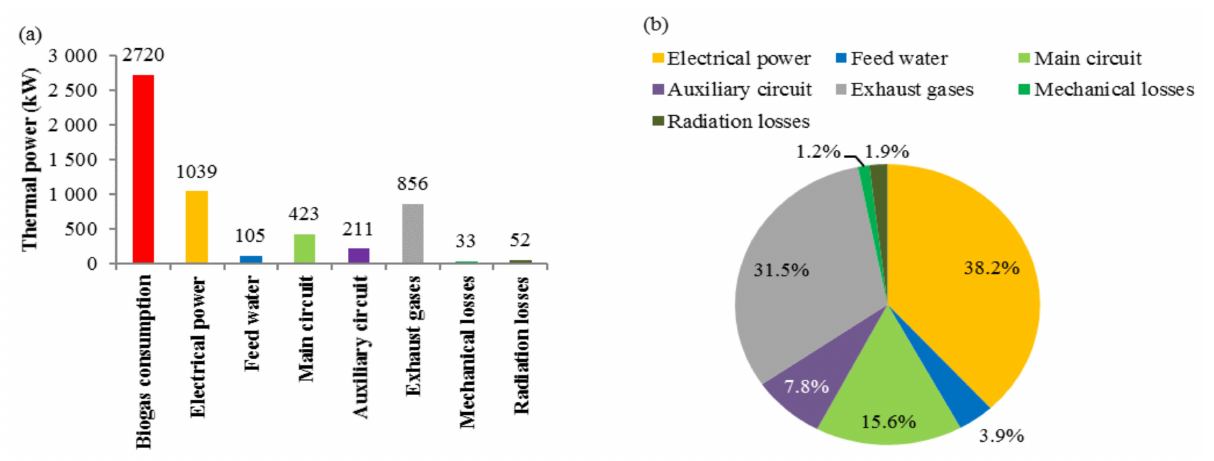
Figure 6. Energy balance of the biogas engines. ( a ) Parameters in absolute value; ( b ) Parameters expressed as